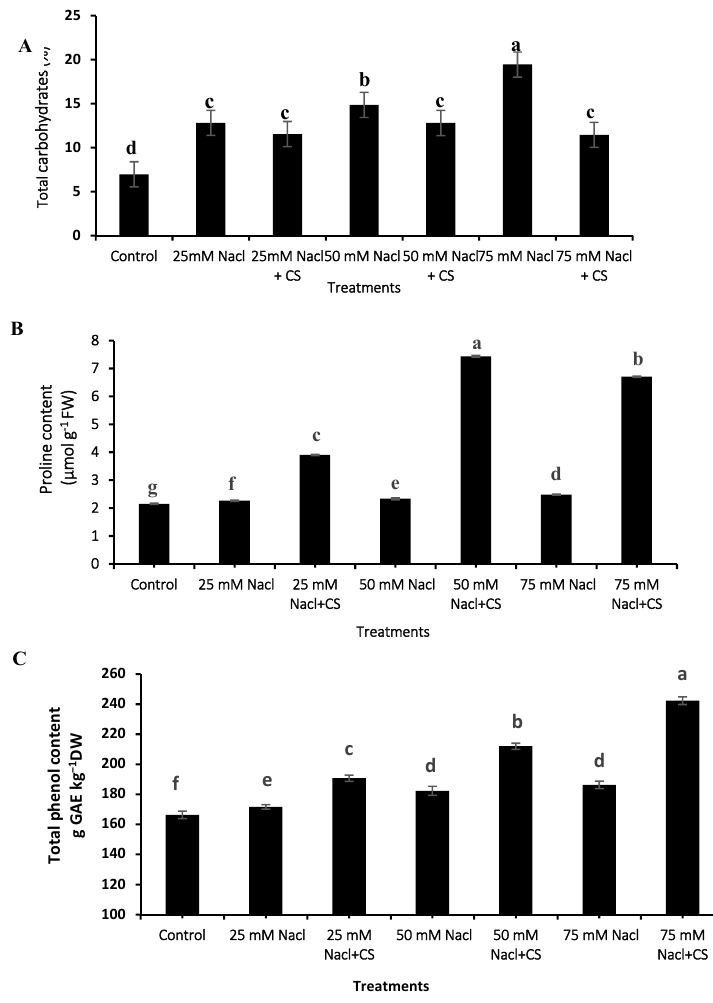
Figure 5. Total carbohydrates ( A ), proline content ( B ) and total phenol content ( C ) of Moringa oleifera exposed to salt stress and sprayed with chitosan (CS) at 1% concentration. Values are means ± SD of two experiments ( n = 6). Columns with different letters are statistically different from each other according to LSD test at p ≤ 0.05.